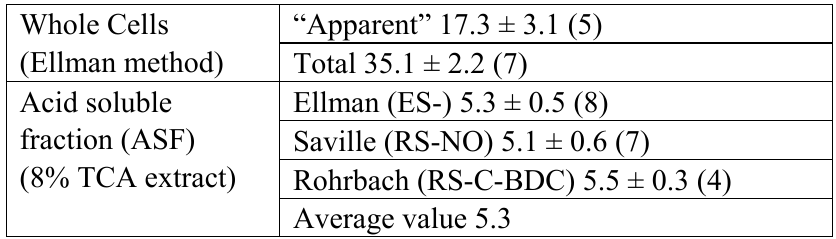
Table 1. LNCap cellular thiol content—femtomoles per